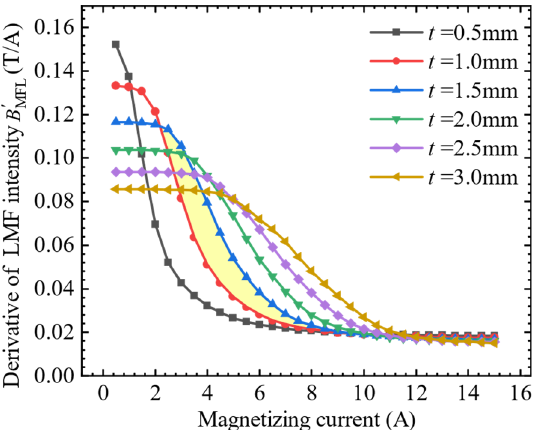
Figure 9. The relationship between the derivative of LMF intensity 𝐵 MFL′ and the magnetizing current with iron plates of different thicknesses.